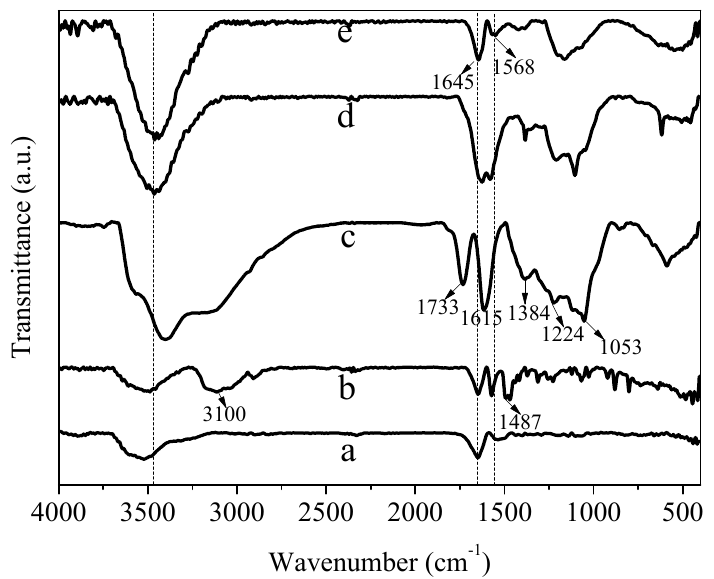
Figure 1. FTIR spectra of ( a ) silver nanowires (AgNWs); ( b ) NH 2 -AgNWs; ( c ) graphite oxide (GO); ( d ) AgNWs/GO-2 and ( e ) AgNWs/GNs-2.